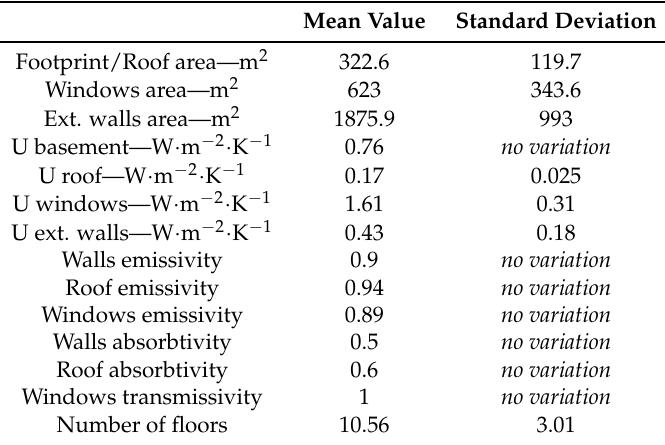
Table 1. District main input parameters statistics for OMEGAlpes.